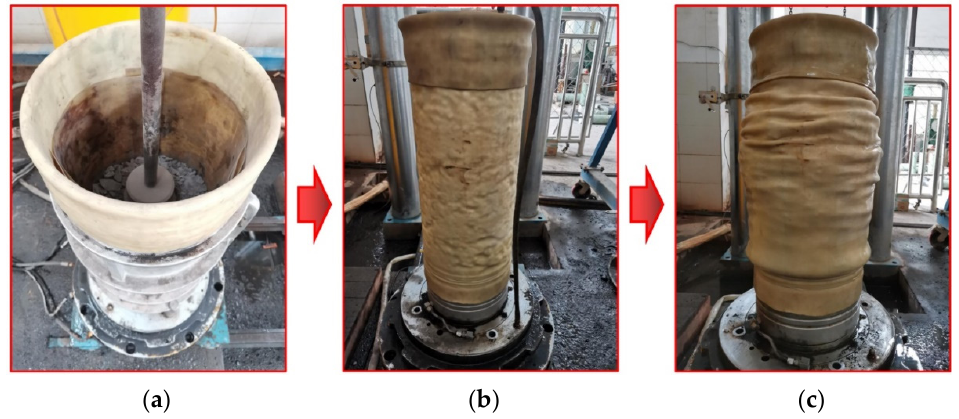
Figure 5. The process of the large triaxial tests: ( a ) compacting in the mold; ( b ) the prepared sample; ( c ) failed sample after the test. Table 1. Test scheme design.